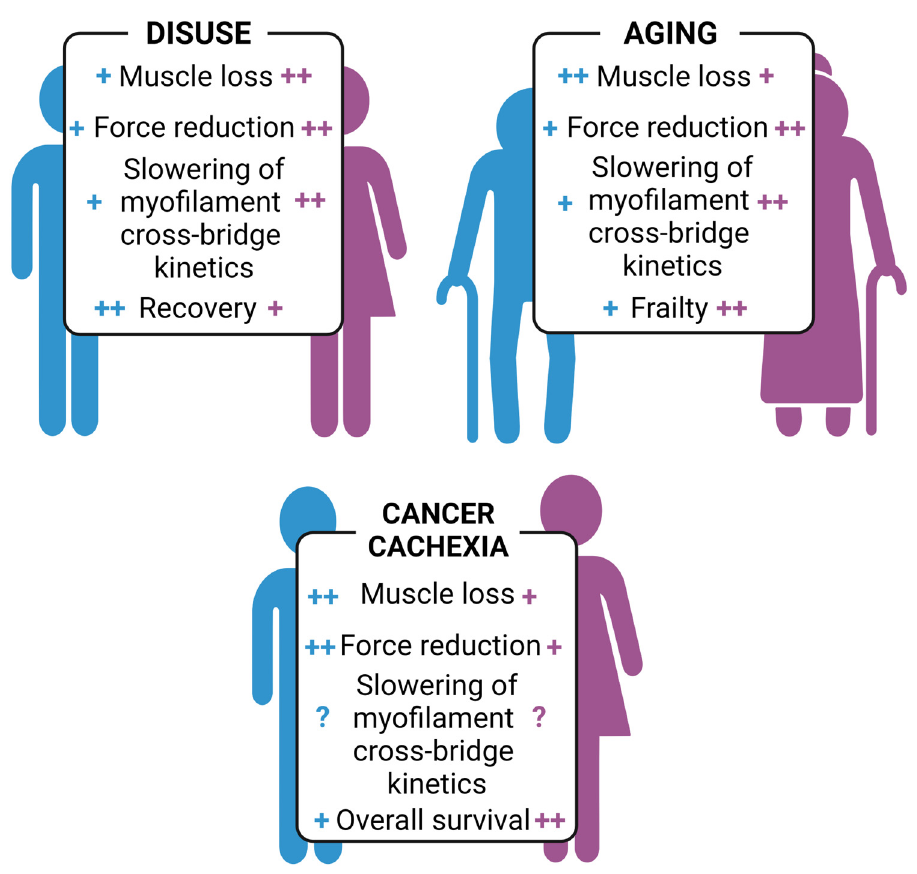
Figure 2. Sex differences in the response to disuse/unloading, age-related sarcopenia, and cancer cachexia. ++ as compared to + refers to a more pronounced feature in the corresponding sex (blue color for men, pink color for women); ? means no consistent data are available .